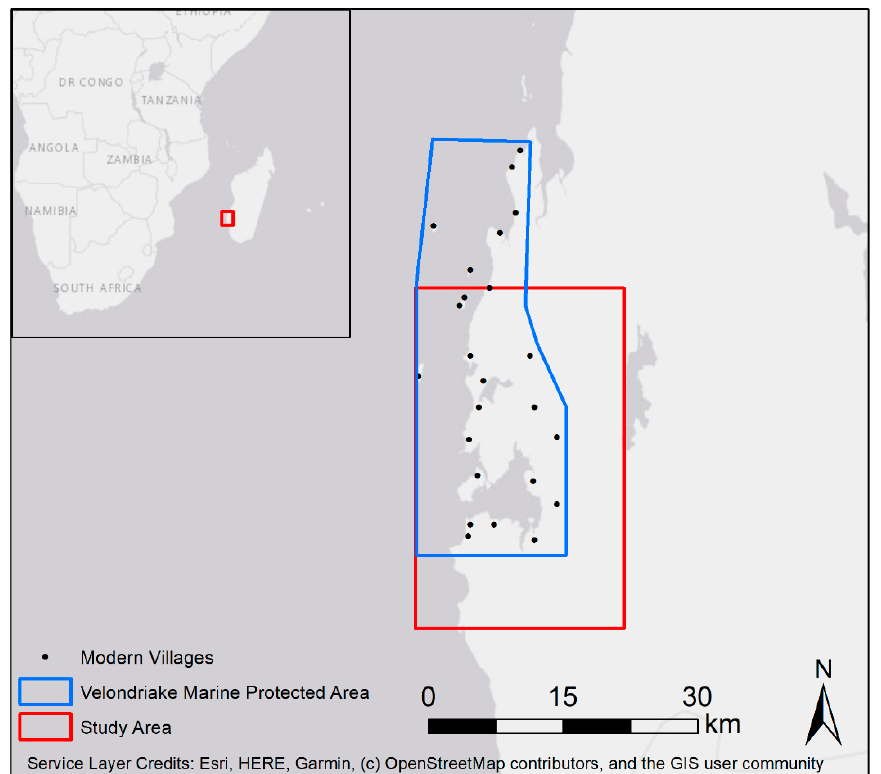
Figure 1. Map of study region in southwest Madagascar. The region contains the Velondriake Marine Protected Area and has been increasingly documented by archaeologists over the past several years.